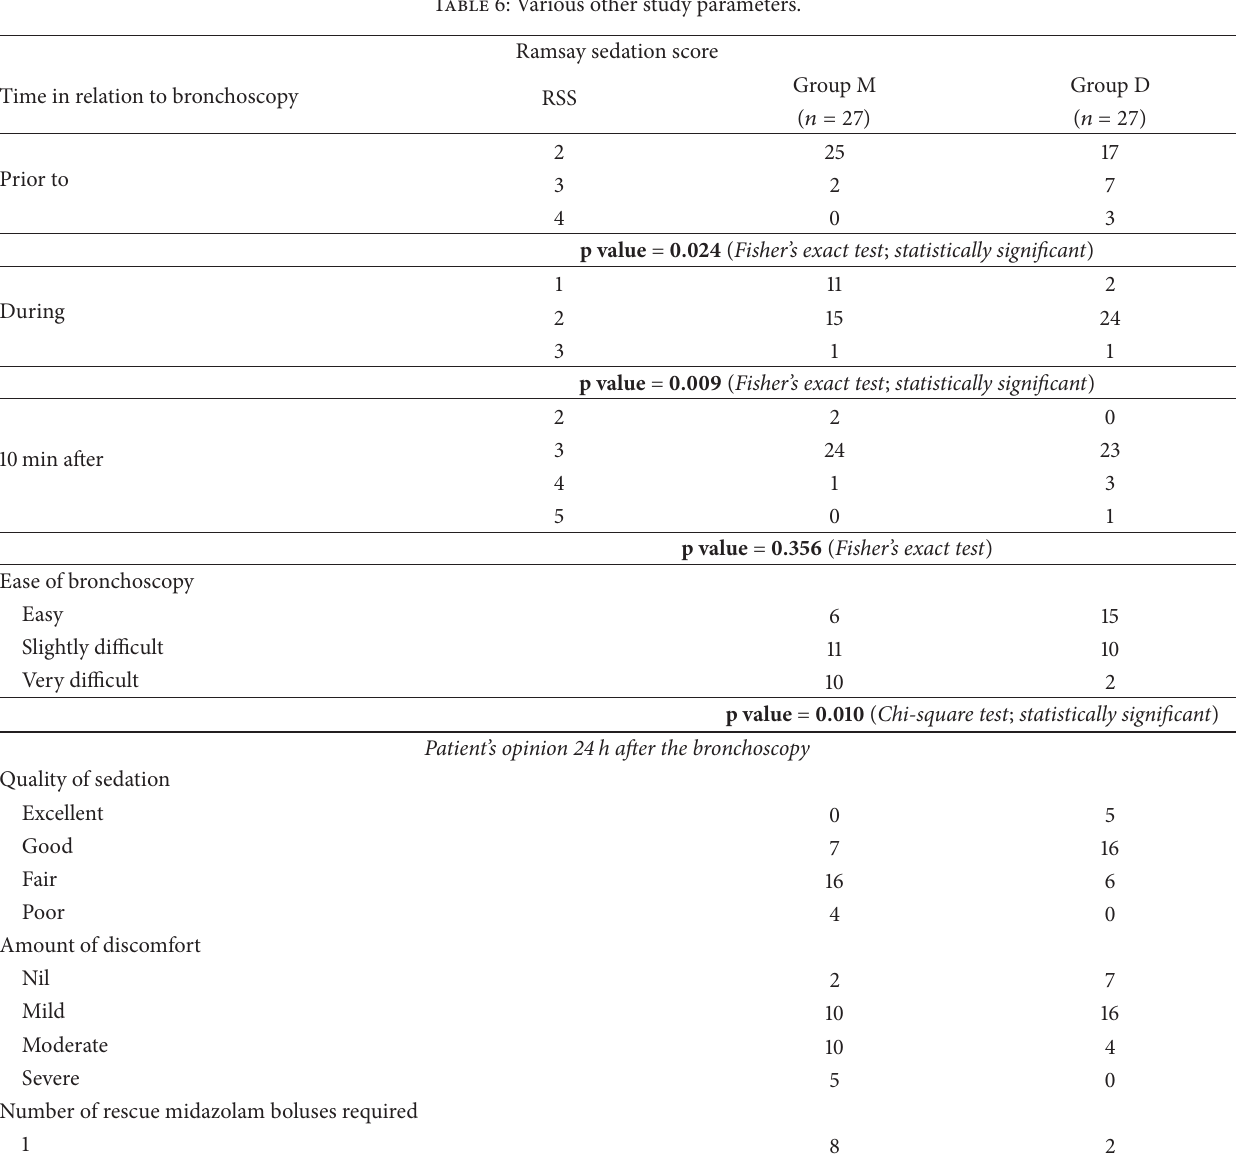
Table 6: Various other study